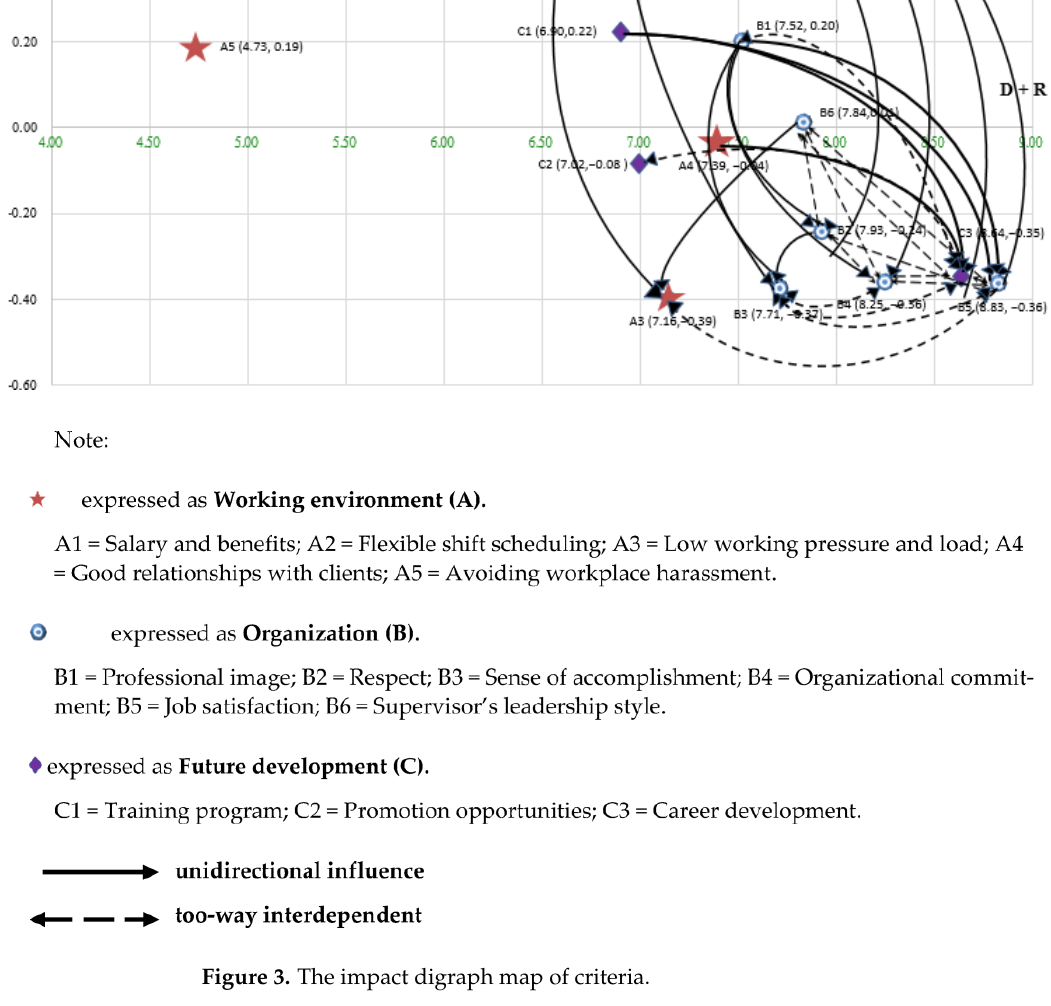
Figure 3. The impact digraph map of criteria.